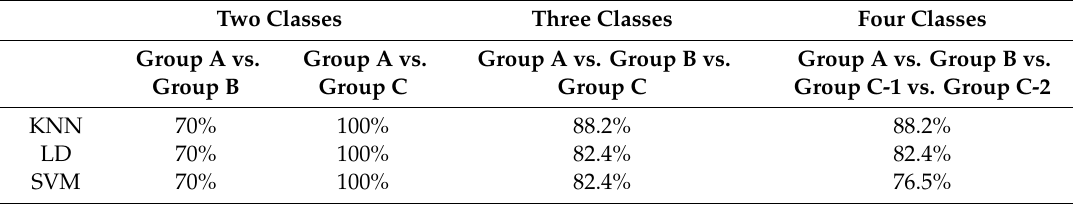
Table 3. Classification accuracy using the 2nd PC peak value and 3rd PC peak